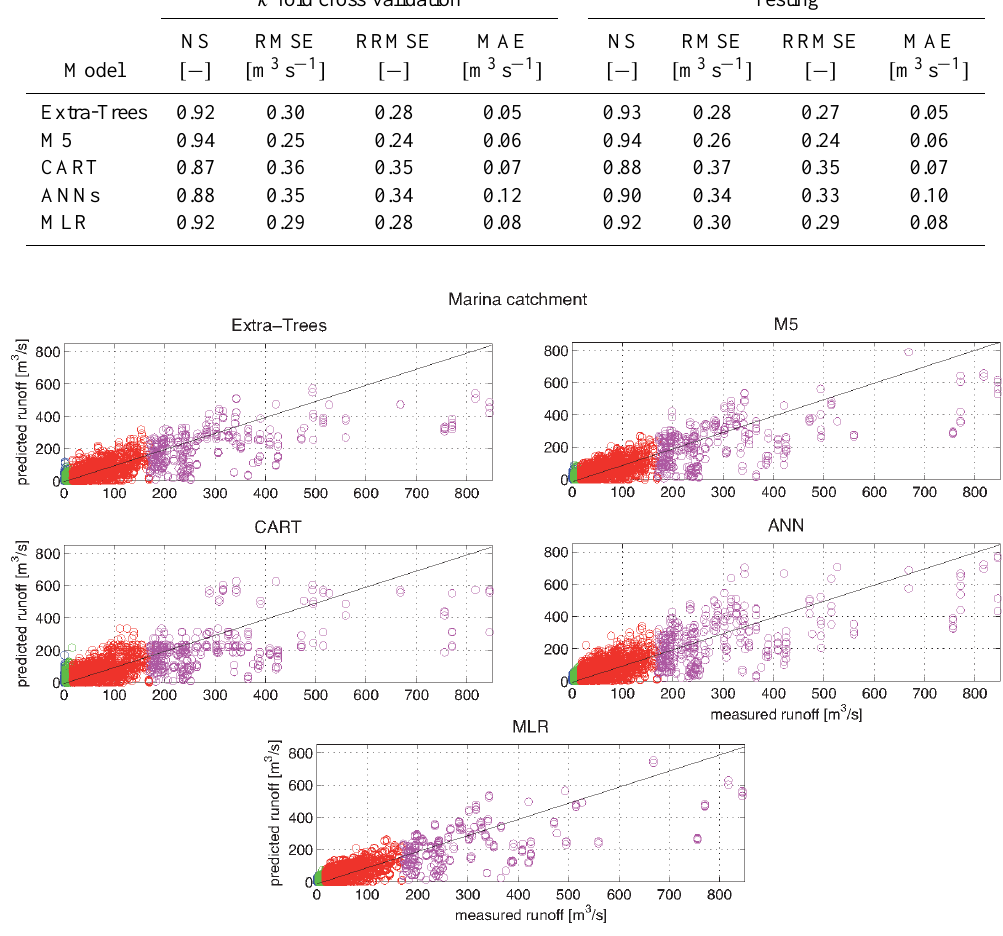
Table 7. k fold cross-validation (with k =10) and testing results of Extra-Trees and benchmarking models for Canning River dataset. k -fold cross-validation